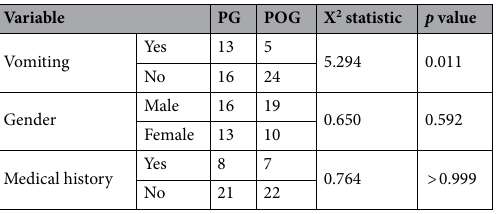
Table 2. Frequency of complication, gender and medical history between the two groups.